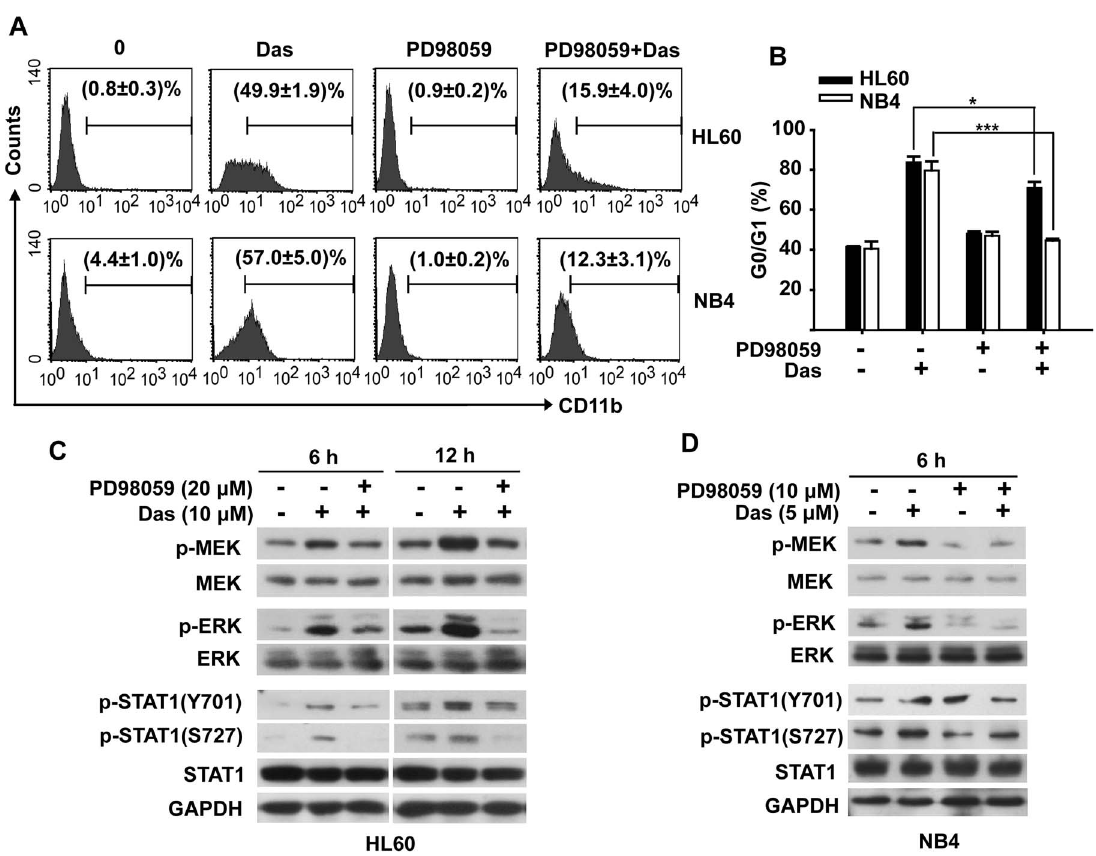
Figure 7. Dasatinib-induced AML differentiation requires MEK/ERK-dependent activation of STAT1. HL60 cells were treated with dasatinib (10 m M) in the presence of PD98059 (20 m M) for 72 h, and NB4 cells were treated with dasatinib (5 m M) in the presence of PD98059 (10 m M) for 48 h. HL60 and NB4 cells were pretreated with PD98059 for 1 h, and then incubated with dasatinb. (A) The percentages of CD11b expression cells were determined as described. Data presented are the mean 6 SD of three independent experiments. (B) Cell cycle proportion was analyzed as described. Data presented are the mean 6 SD of three independent experiments. *** P , .001, * P , .05. (C) and (D) The expression of p-MEK, p-ERK, p- STAT1(Y701) and p-STAT1(S727) as well as their total proteins in HL60 and NB4 cells were analyzed by Western blotting. The experiments were repeated three times and the data show the representative results. (Fig. 5B). Taken together, dasatinib-induced activation of STAT1